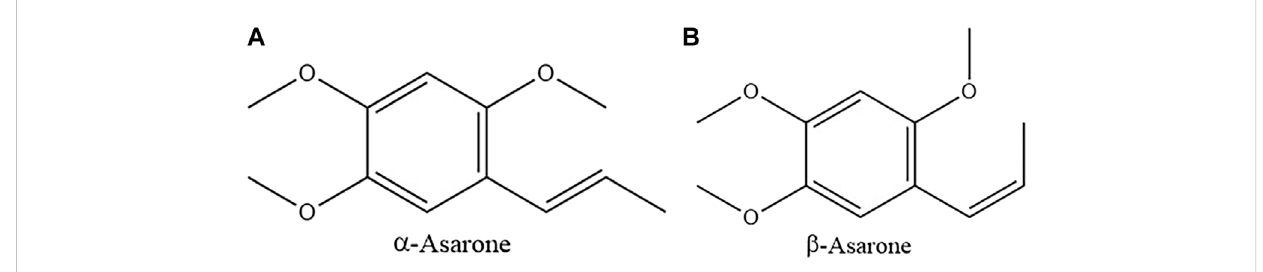
FIGURE 1 The chemical structure of α -asarone (PubChem CID: 636822) (A) , and β -asarone (PubChem CID: 5281758) (B)